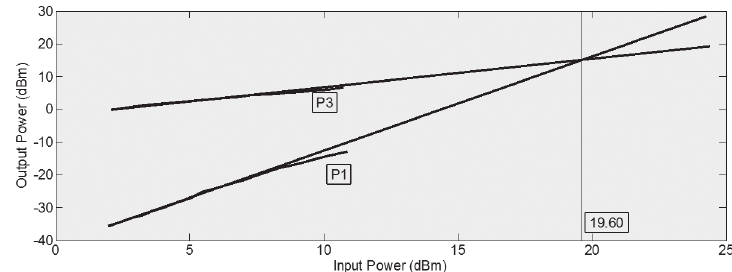
Figure 7 - Linearity of the